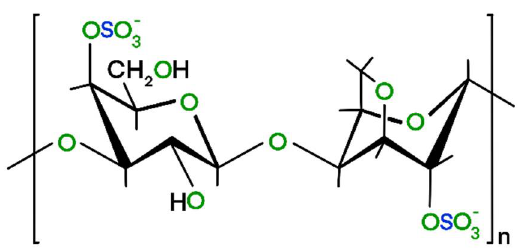
Figure 1. The chemical structure of a monomer unit of ι-carrageenan.